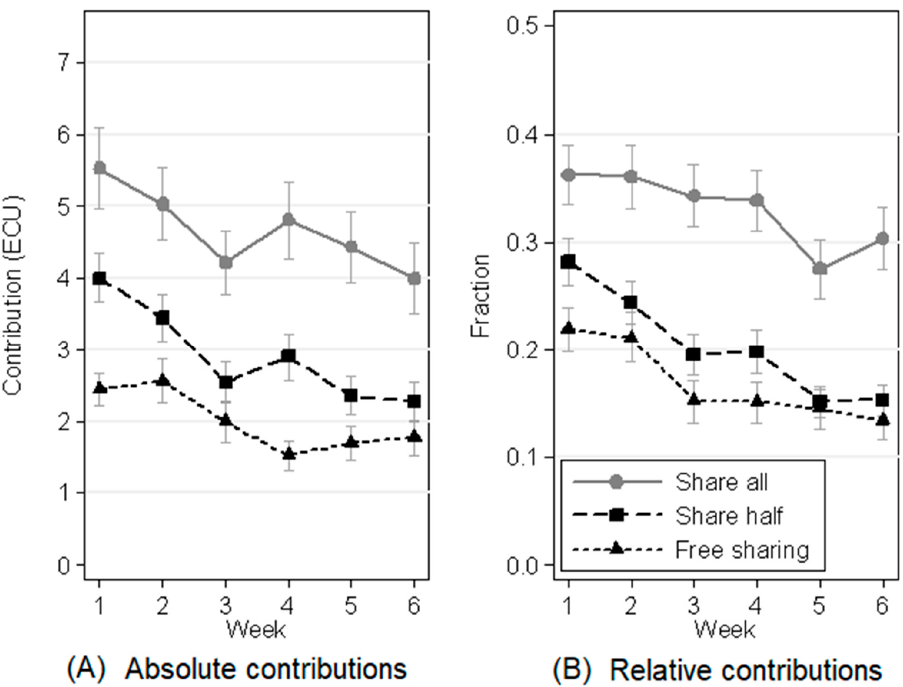
Figure 1. Absolute and relative contribution over time. Waiters’ observed contribution under different sharing rules over time (each week contains 7 rounds). Mean contribution under Free sharing (R1, triangles), under Share Half (R2, squares) and under Share All (R3, circles). Standard error bars in gray. ( A ) Absolute contributions are sensitive to sharing rules and show an overall decrease over time. ( B ) Relative contributions show the same trends.